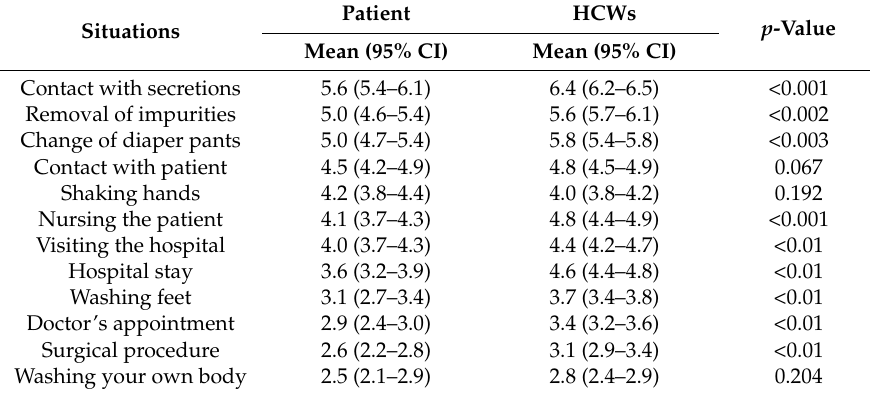
Table 5. The level of the need for hand hygiene felt after the occurrence of contaminated hands between patients and HCWs in particular situations associated with health and disease, on a scale of 1 (clean hands) to 7 (very dirty